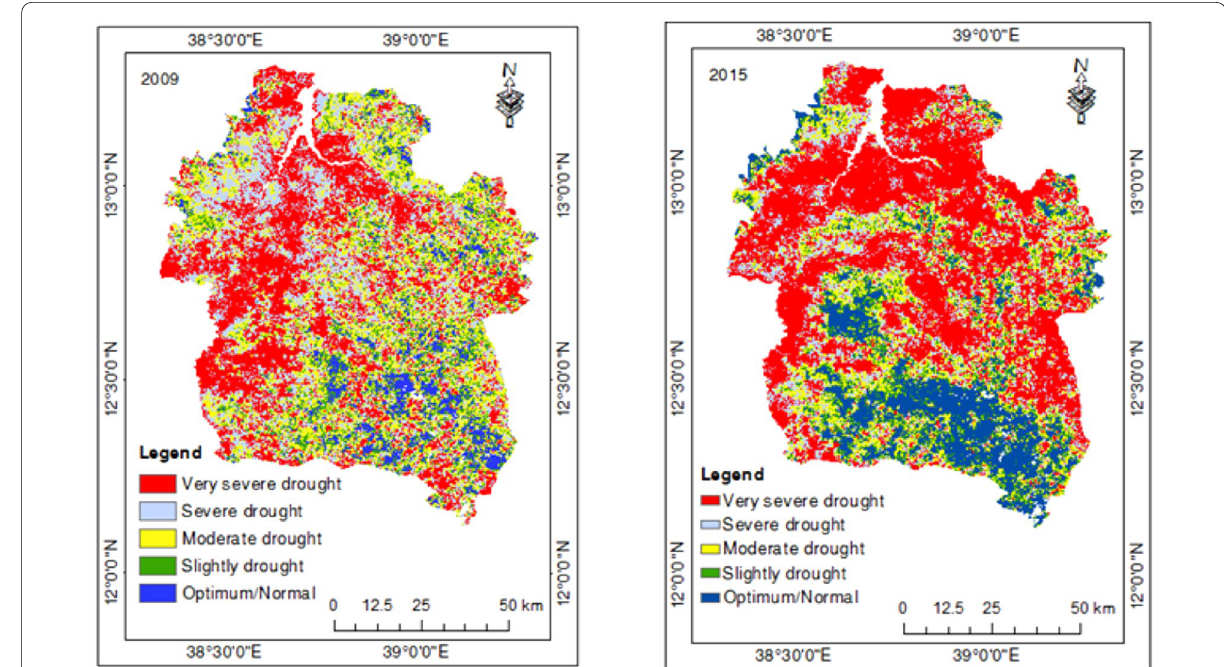
Fig. 7 Spatial pattern of agricultural drought expressed by Vegetation condition index during drought year 2009 and 2015